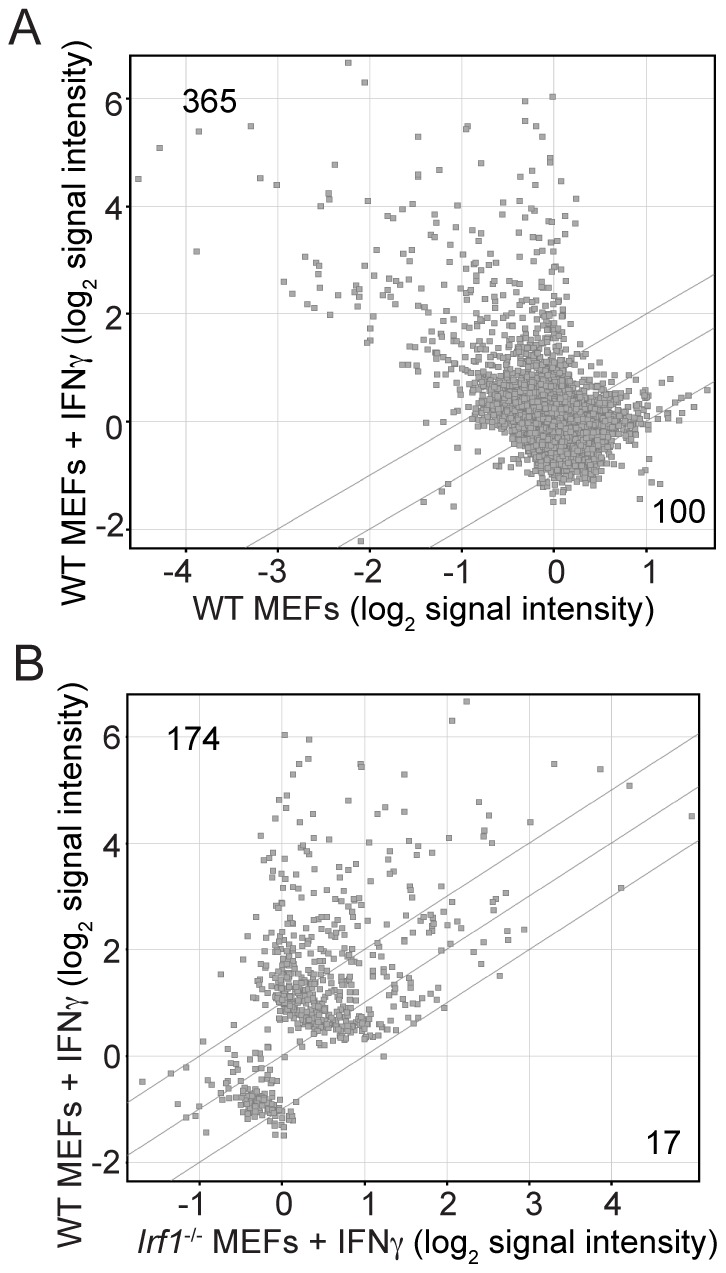
Comparative expression of transcripts from WT and Irf1
−/− MEFs.As indicated, cells were stimulated with IFNγ for 18 hours or left unstimulated. All cells were subsequently infected with S. flexneri for 6 hours prior to extraction of RNA. (A) Scatter plot of fluorescence intensities of probe sets from unstimulated and IFNγ-stimulated WT MEFs during infection. Dots represent data from individual probe sets and are plotted as normalized, log-2 transformed values. Outer diagonal lines indicate 2-fold differences (p<0.05, ANOVA) in gene expression of a given probe set between different conditions. All probe sets passing minimum threshold conditions during analysis are shown in the plot (see Materials and Methods). (B) Scatter plot of fluorescence intensities of probe sets from IFNγ-stimulated WT and IFNγ-stimulated Irf1
−/− MEFs during infection. Probe sets shown in panel B are a subset of the total probe sets shown in panel A and represent only IFNγ-dependent genes that were identified in A. Outer diagonal lines indicate 2-fold differences (p<0.05) in gene expression of a given probe set between different conditions. Microarray data shown are from one experiment out of 2 independent experiments.